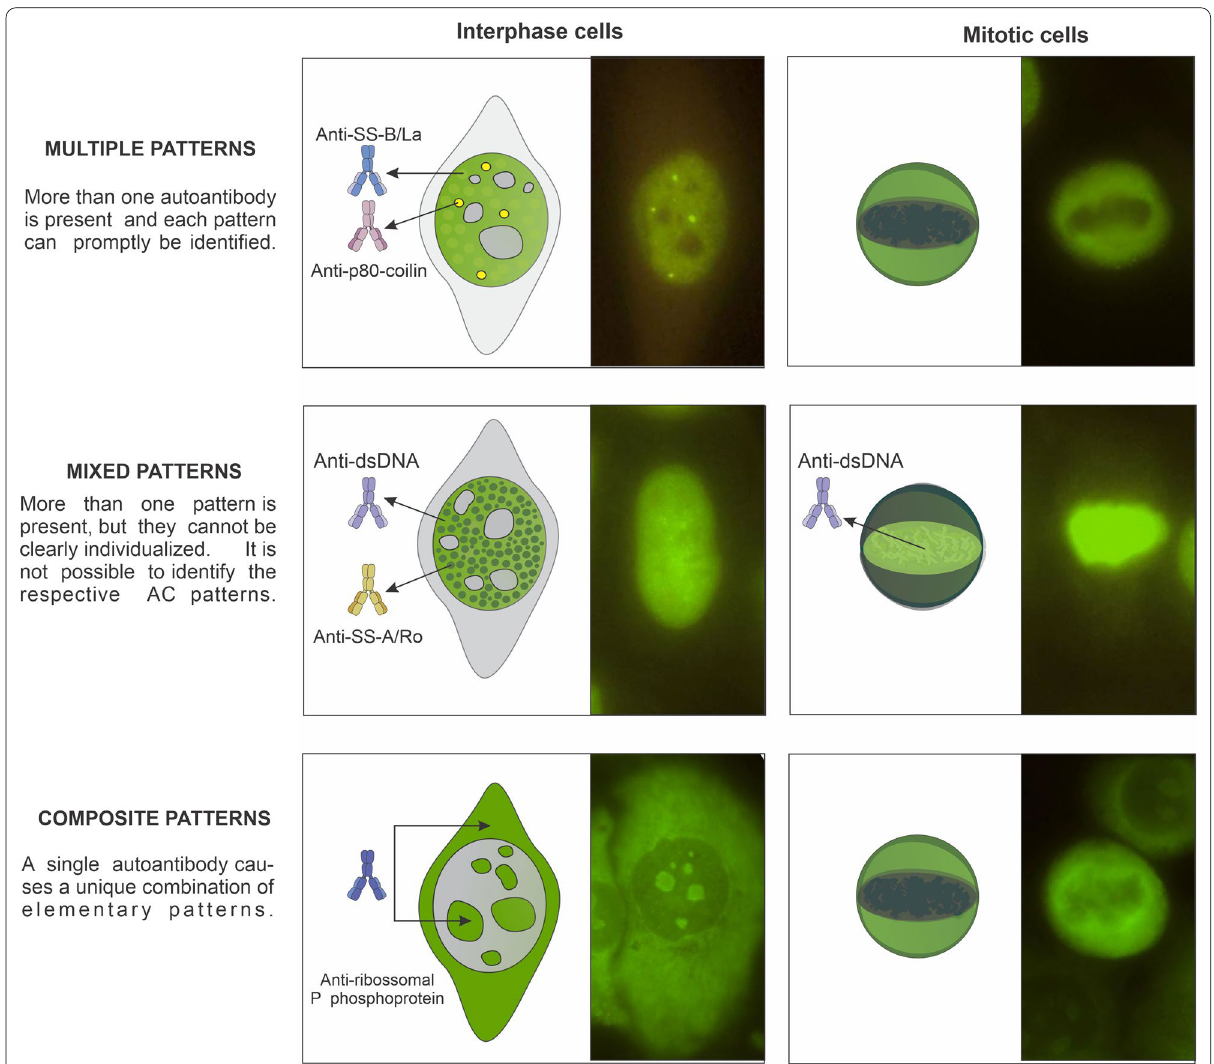
Fig. 1 Schematic conception of three examples of complex patterns (multiple, mixed and composite) showing relevant details about staining on interphase and mitotic